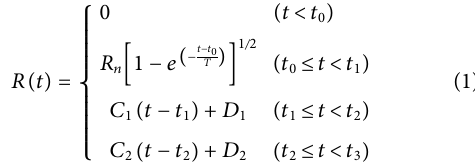
FIGURE 2 Quench/recovery model of the superconducting coil used in the SFCL (Yang et al., 2017), (Chen et al.,